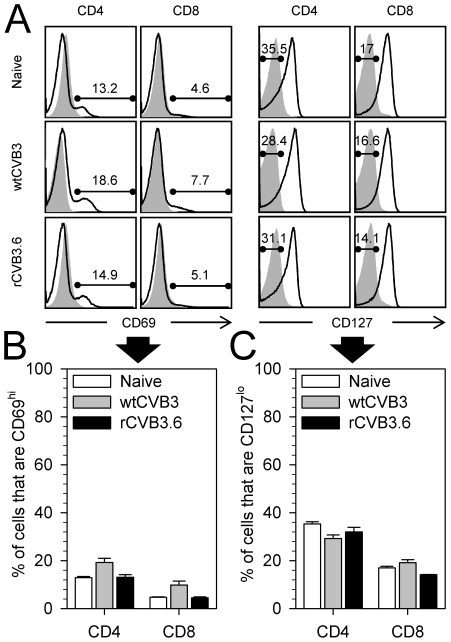
No significant change in CD69 or CD127 expression on T cells 8 days after CVB3 infection.Mice were infected with wtCVB3 or rCVB3.6, and the extent of T cell activation was analyzed on day 8. (A) CD69 and CD127 expression profiles of CD4+ and CD8+ splenocytes were compared for naïve and virus-infected mice. CD4+ and CD8+ cells were gated, and representative histograms are shown. CD69/CD127 staining is shown by solid black lines, and isotype control staining is shown in gray. The numbers indicate the percentage of gated T cells that are CD69hi (left columns) or CD127lo (right columns). The frequency of CD69hi (B) or CD127lo (C) CD4+ or CD8+ T cells in the spleen was determined for each group of mice. Data are representative of 2 independent experiments, and show the mean + SE for 3–11 mice per group; statistical analyses (ANOVA) revealed no significant differences among the groups.